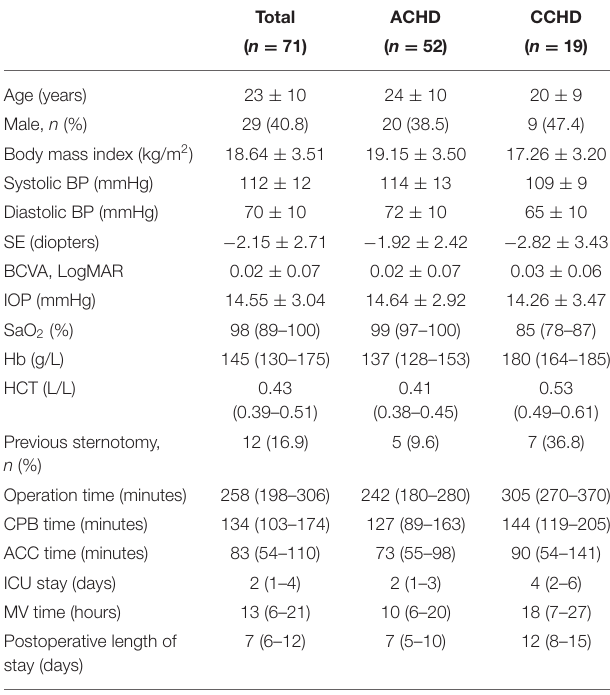
TABLE 1 | Baseline characteristics of